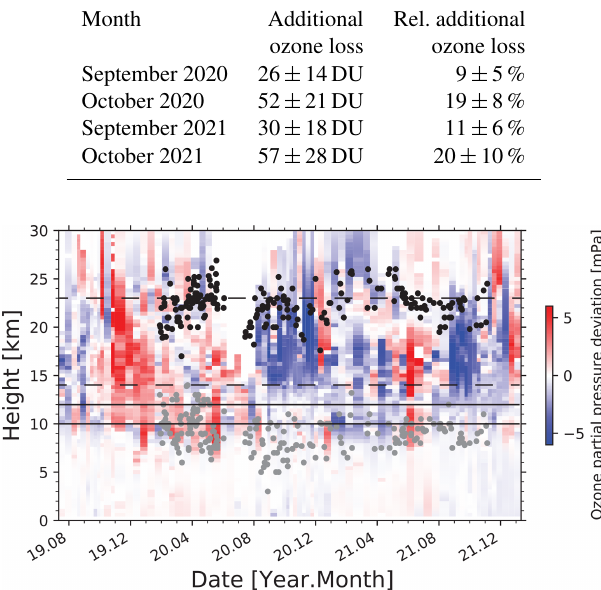
Figure 6. Deviation of each individual ozone profile from the re- spective long-term (2010–2019) monthly mean ozone profile. Mea- surements at the Neumayer station (70.6 ◦ S) are used. Dashed and solid horizontal lines mark the main PSC height range (14–23km) and the PSC-free zone (10–12km). The base (gray dots) and top heights (black dots) of the Australian smoke layer measured with Polly at Punta Arenas on a daily basis indicate the smoke-polluted height range. Gaps in the lidar data (e.g., in July 2020) are caused by cloudy weather and instrumental